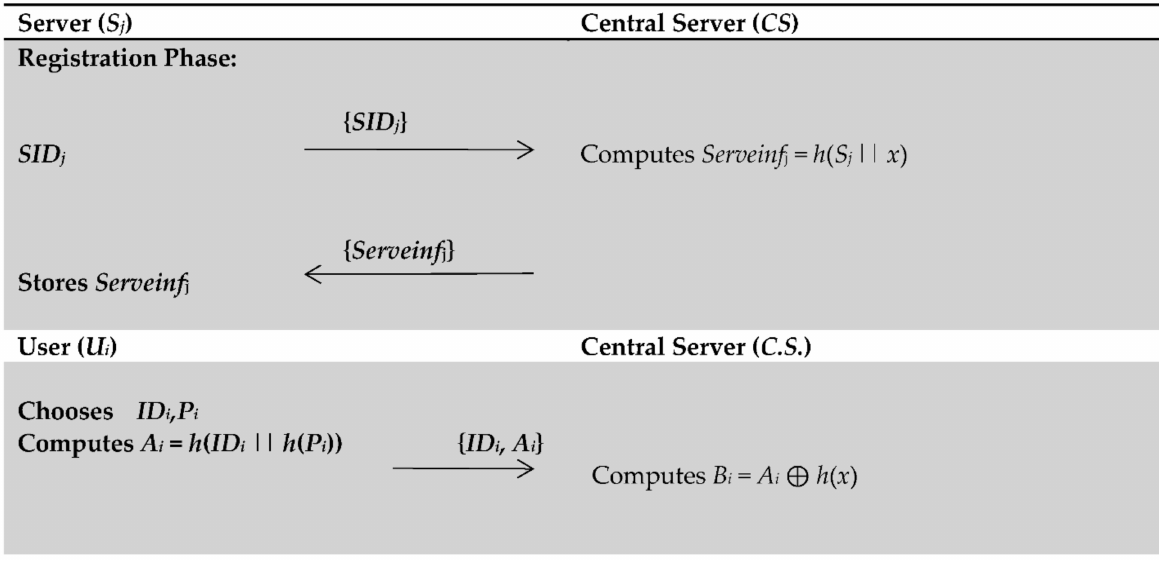
Figure 1. Registration